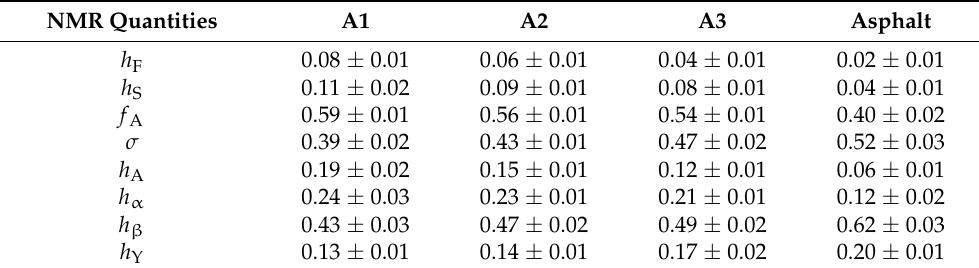
Table 5. Calculated values for the average molecular structure of the extracted asphaltenes (A1, A2 and A3) and the base asphalt according to their NMR spectra 1 .